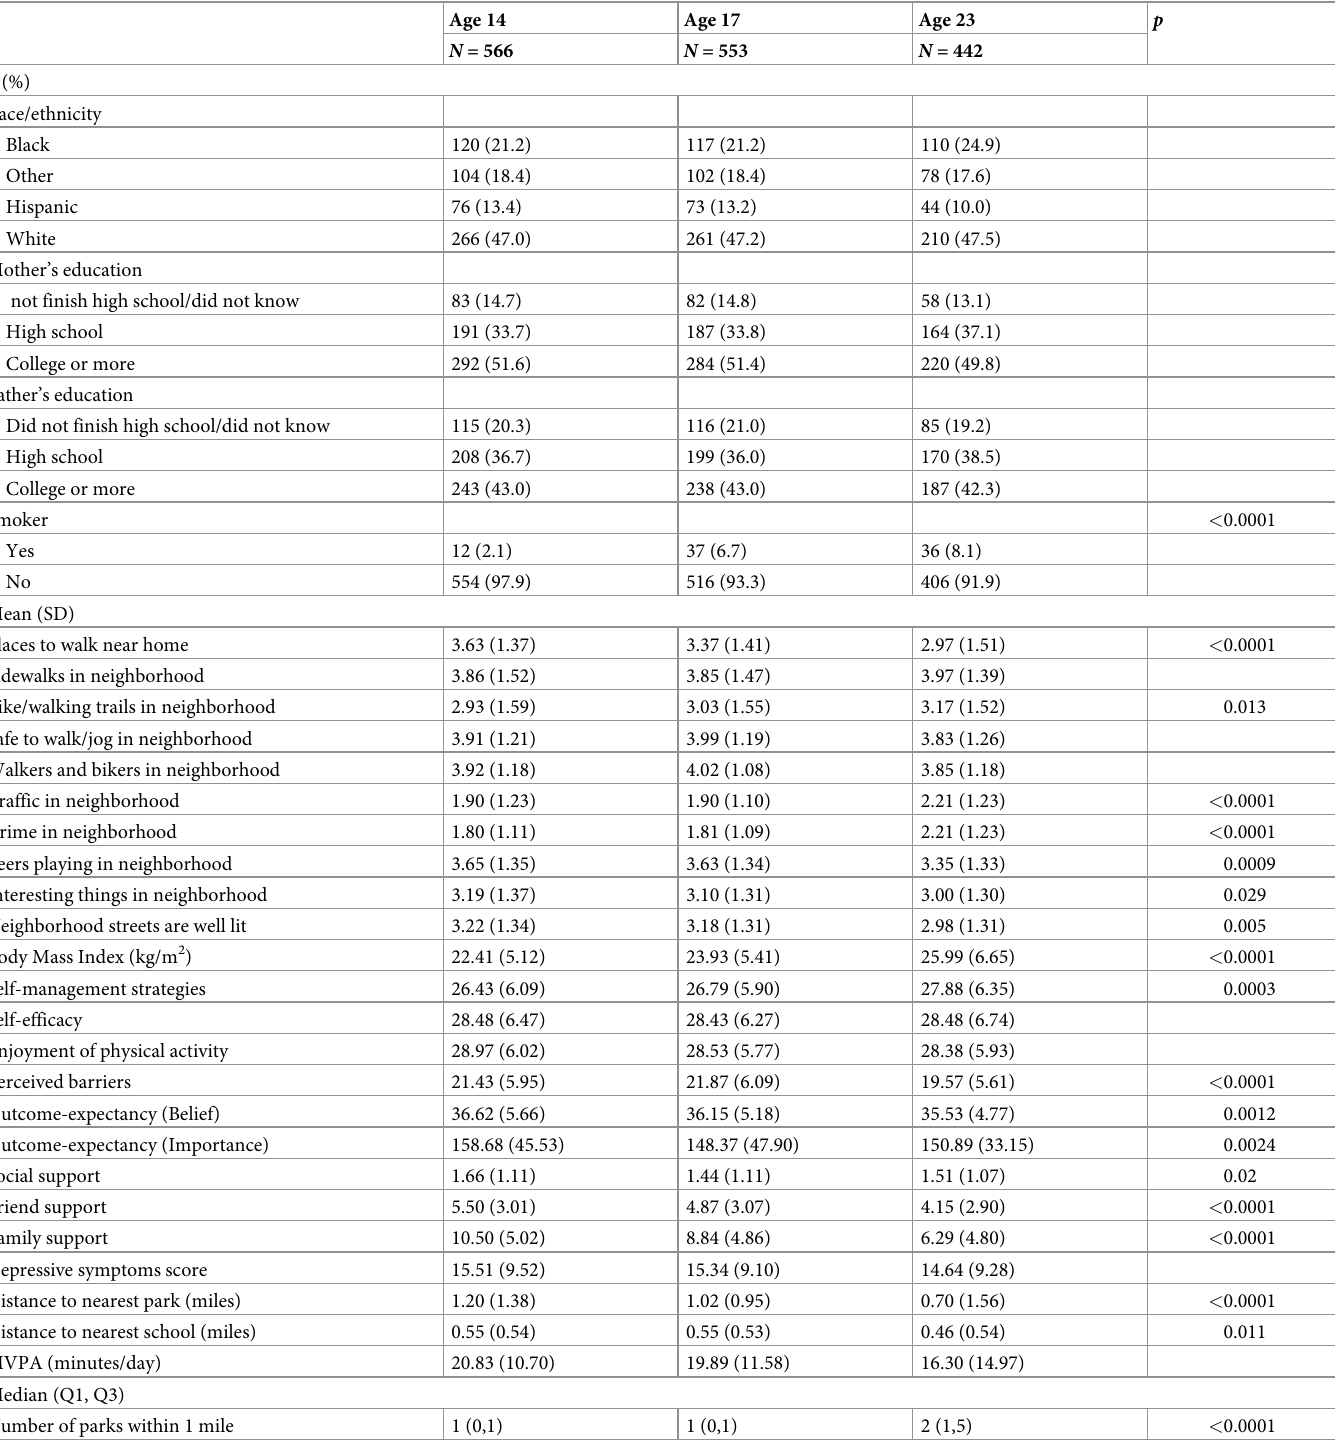
Table 1. Demographic, behavioral, psychosocial and neighborhood characteristics at ages 14, 17, and 23